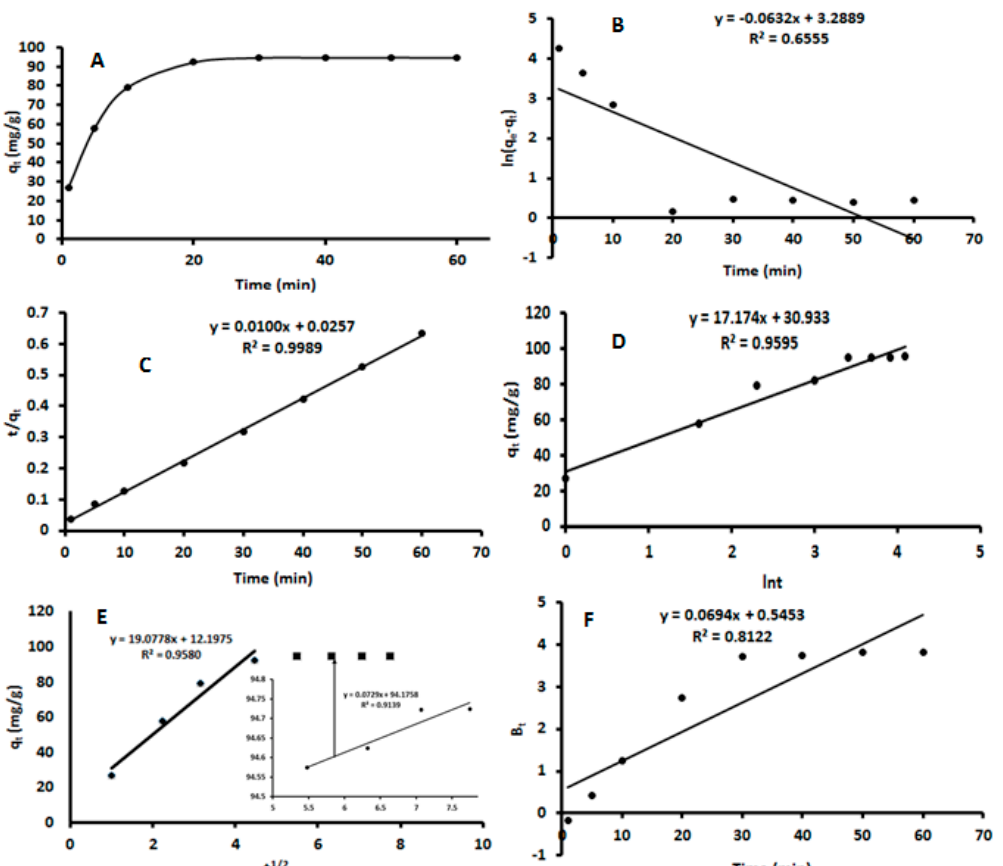
Figure 6. Adsorption kinetics plots for the sorption of β -estradiol using akaganeite: ( A )—adsorption kinetics model; ( B )—pseudo-first order linear model; ( C )—pseudo-second order linear model; ( D )—Elovich linear model; ( E )—intraparticle diffusion linear model; ( F )—Boyd linear model. Table 3. Kinetic models and parameters investigated in the present study.